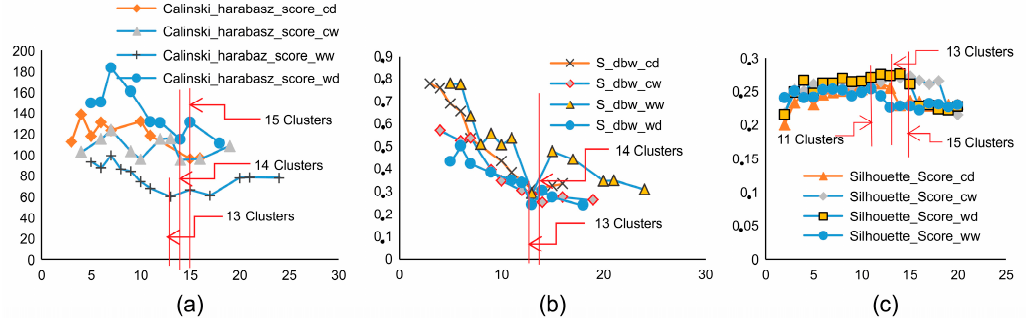
Figure 6. The cluster validity indices / scores for cold-dry (cd), cold-wet (cw), warm-wet (ww) and warm dry (wd) seasons ( a ) Calinski–Harabasz score, the number of clusters valid are marked corresponding to the minimum score in each season ( b ) S Dbw score, the number of clusters valid is marked corresponding to minimum score in each season and ( c ) Silhouette Score the number of clusters valid is marked corresponding to maximum score in each season.